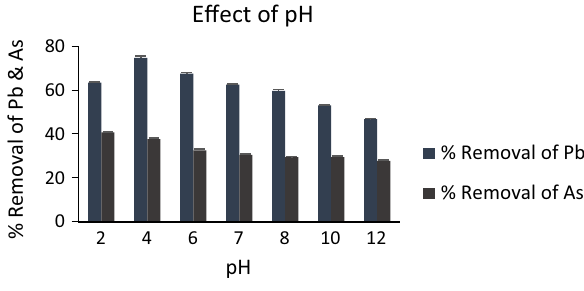
Fig. 6 Effect of pH on adsorption of Pb and As. Experimental